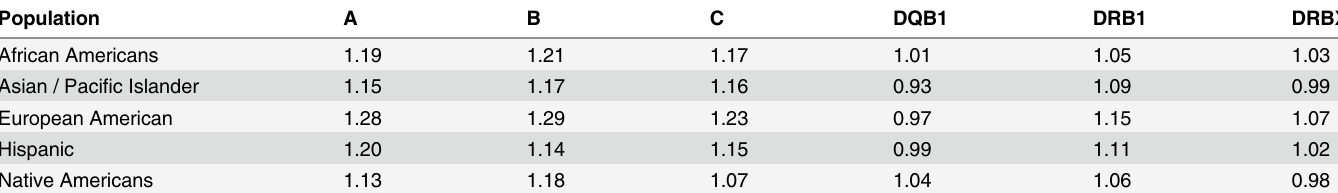
Table 4. Estimate of α for the allele frequency distribution for all allele types and for each combined sub population. Population A B C DQB1